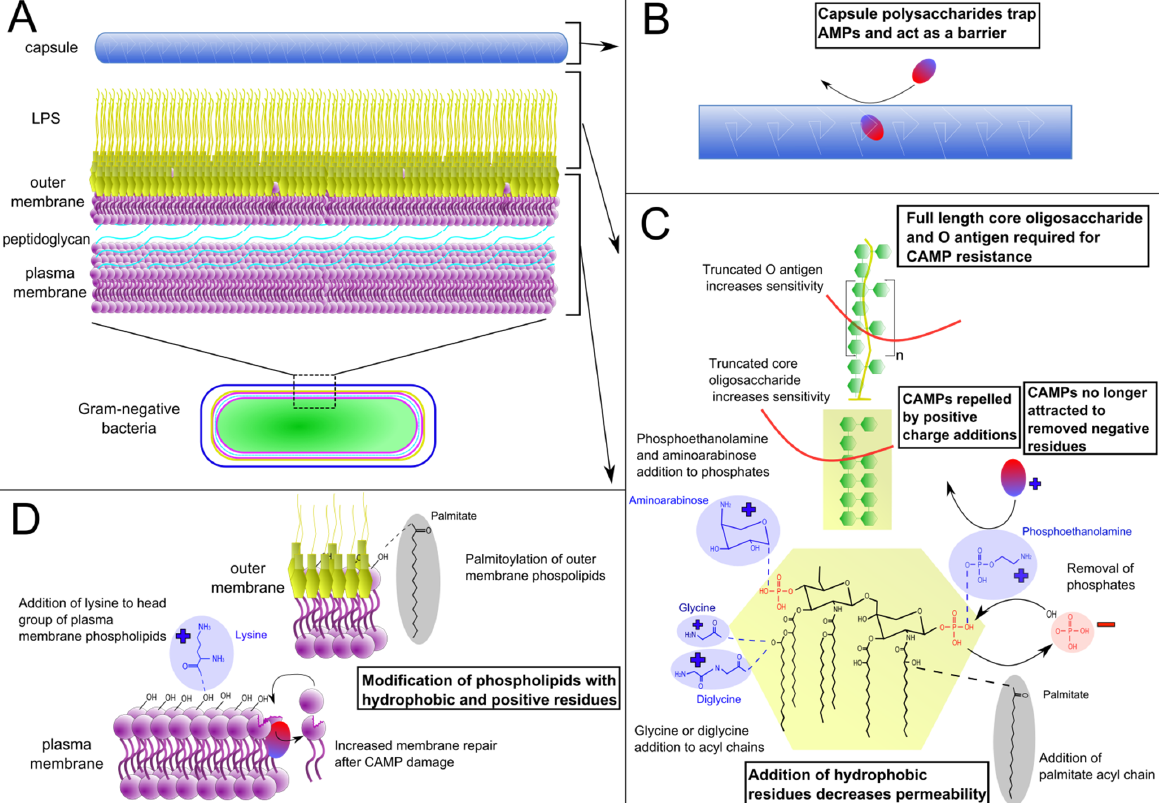
Figure 1. Bacterial surface modifications that enhance cationic antimicrobial peptide (CAMP) resistance. Gram-negative bacterial cell wall structure ( A ), with magnification of ( B ) capsule, ( C ) lipopolysaccharide, and ( D ) outer and plasma membranes. Lipopolysaccharide (LPS) structure varies greatly across species; depicted is a representative E. coli LPS structure, with modifications from various other